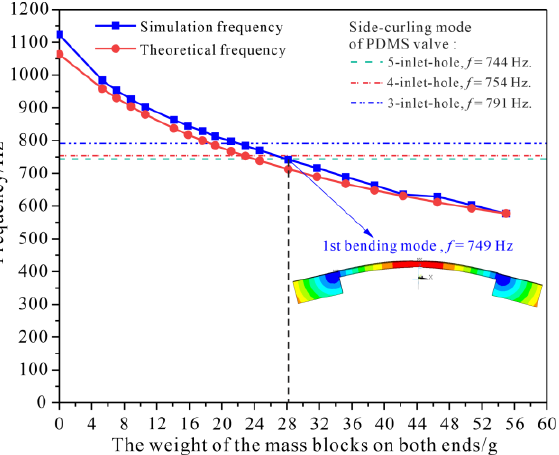
Figure 6. Tuning the first bending resonant frequency of the piezoelectric resonator by adjusting the weight of the mass blocks.